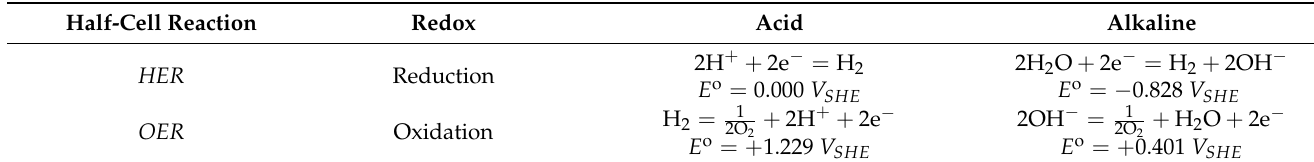
Table 2. The hydrogen evolution reaction (HER) and oxygen evolution reaction (OER) occurring in aqueous acidic and alkaline conditions. Half-Cell